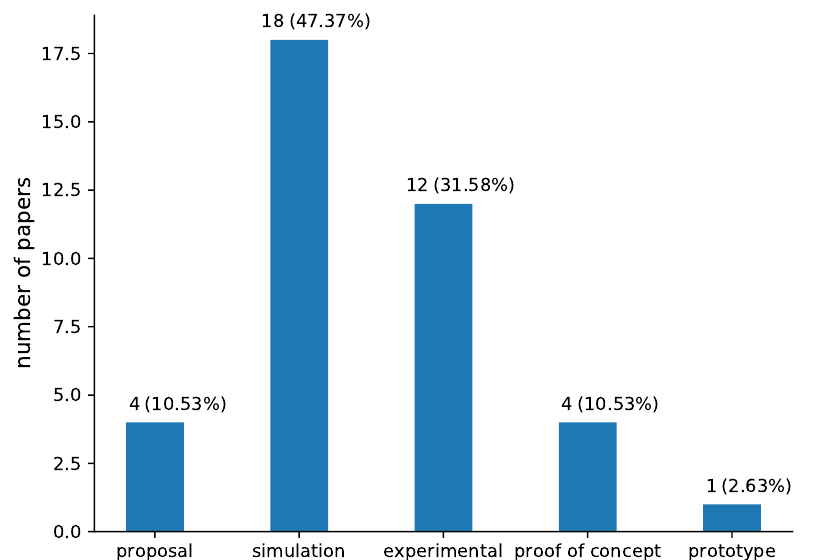
Figure 11. Maturity (RQ7) of the schemes presented in the papers included in our